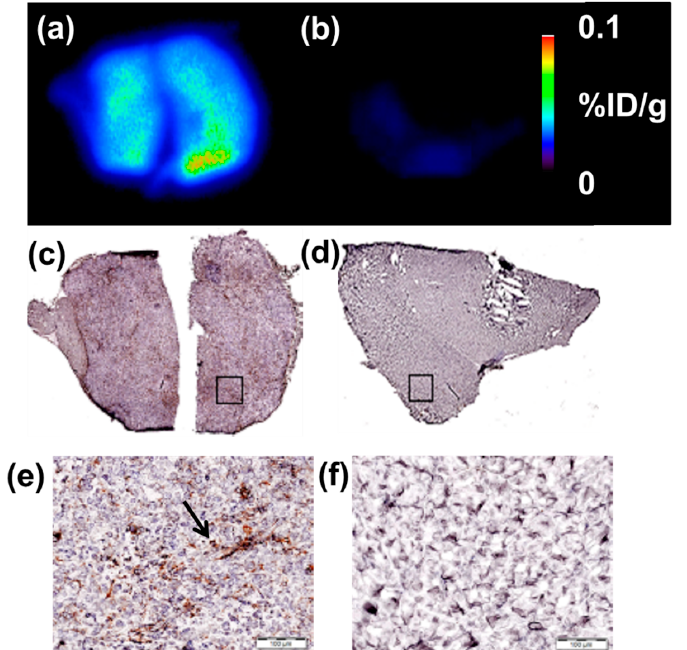
Figure 5. Autoradiography and histology confirm the presence of [ 89 Zr]Zr-Df-Bz-F19 in only FAP + tissues. ( a ) Autoradiography corroborates results of small animal imaging experiments; radioactivity is localized in the FAP + tumor; ( b ) FAP - tissues (e.g., muscle) demonstrated non-specific and minimal accumulation of radioactivity; Macroscopic view of sequential tumor ( c ) and muscle ( d ) slices used to corroborate autoradiographic studies; black squares indicate spatial area where tissue magnification (100×) occurred to observe the presence ( e ) or absence ( f ) of FAP expression in each tissue. Arrows indicate FAP expression.